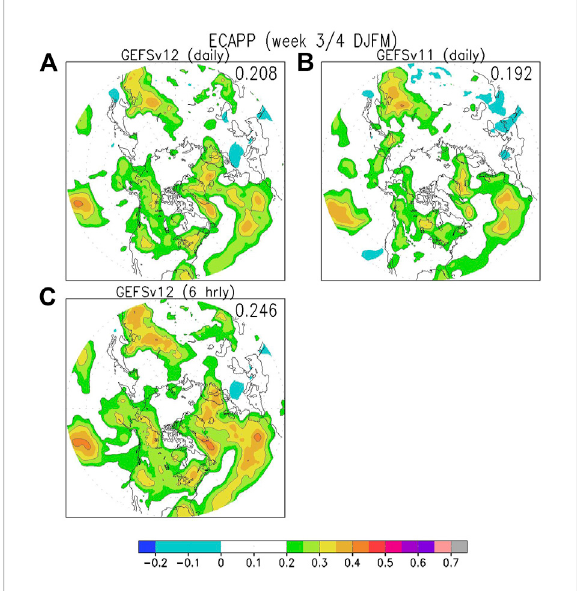
FIGURE 13 (A) ACC scores for weeks 3-4 hindcasts of